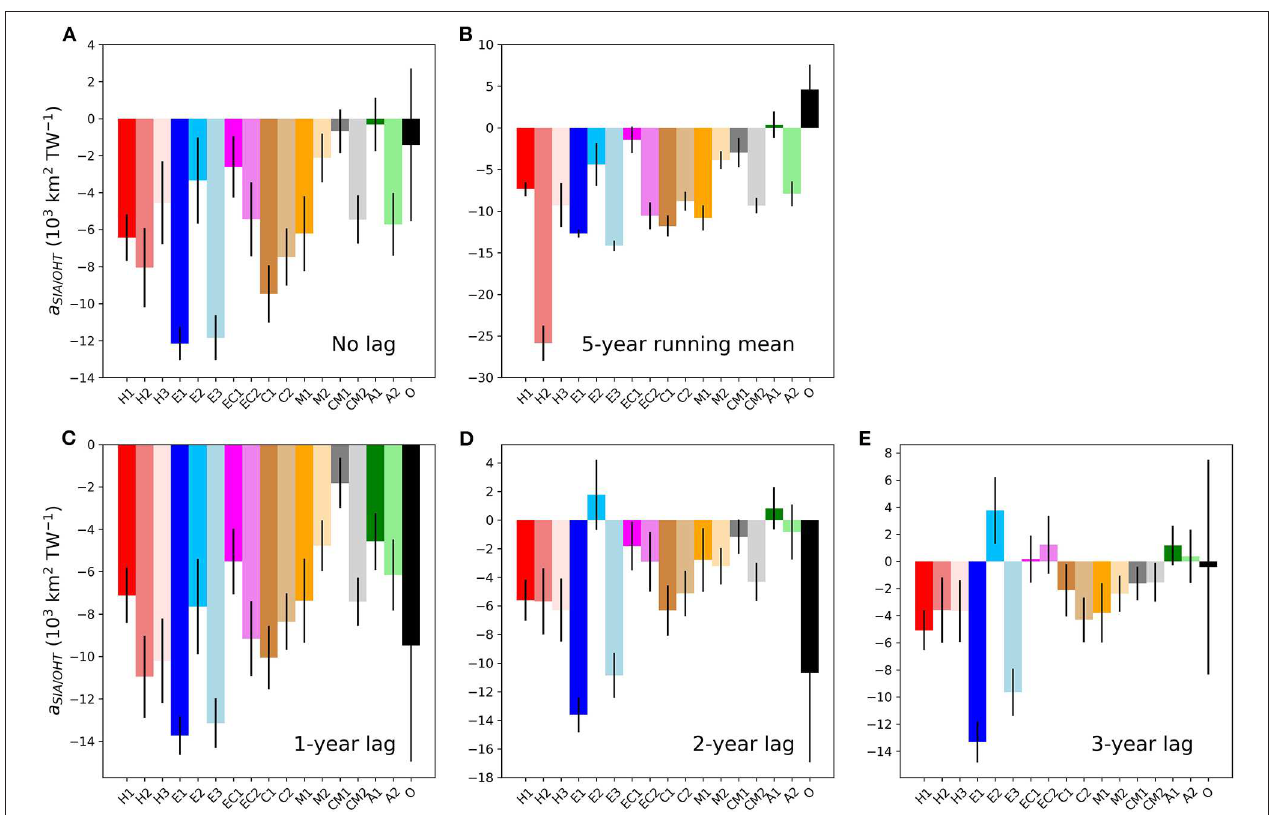
FIGURE 10 | (A) Regression slopes ( a SIA / OHT ) between detrended March Barents sea-ice area and detrended annual mean ocean heat transport (OHT) at the Barents Sea Opening (BSO, large transect) for all HighResMIP hist-1950 model outputs (1950–2014) and observations/renalysis (1993–2010). (B) Same as (A) with 5-year running mean instead of annual mean. (C–E) Same as (A) with OHT leading sea-ice area by (C) 1 year, (D) 2 years, (E) 3 years. The X axis shows the 16 model configurations used (H1 = HadGEM3-LL, H2 = HadGEM3-MM, H3 = HadGEM3-HM, E1 = ECMWF-LR, E2 = ECMWF-MR, E3 = ECMWF-HR, EC1 = EC-Earth-LR, EC2 = EC-Earth-HR, C1 = CNRM-LR, C2 = CNRM-HR, M1 = MPI-HR, M2 = MPI-XR, CM1 = CMCC-HR4, CM2 = CMCC-VHR4, A1 = AWI-LR, A2 = AWI-HR) and observations/reanalysis (O). The black line on top of each bar indicates the standard deviation of the regression